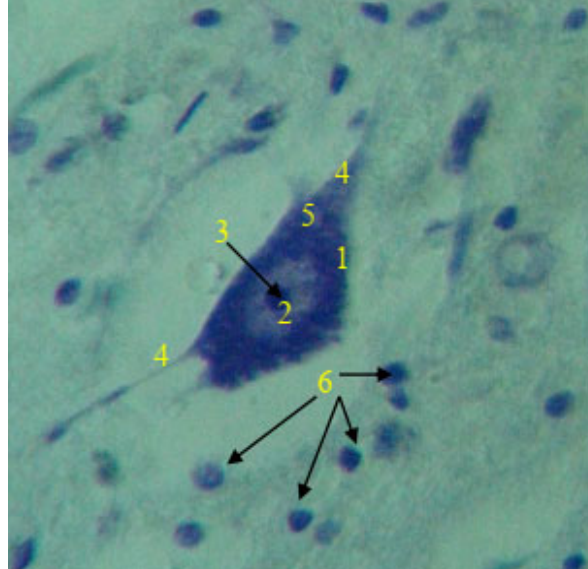
Fig. 3. A fragment of the microscopic structure of the gray area of mature cattle: 1 – gray matter; 2 – lateral horn; 3 – nucleus of a lateral horn. Ramón-y-Cajal. × 120